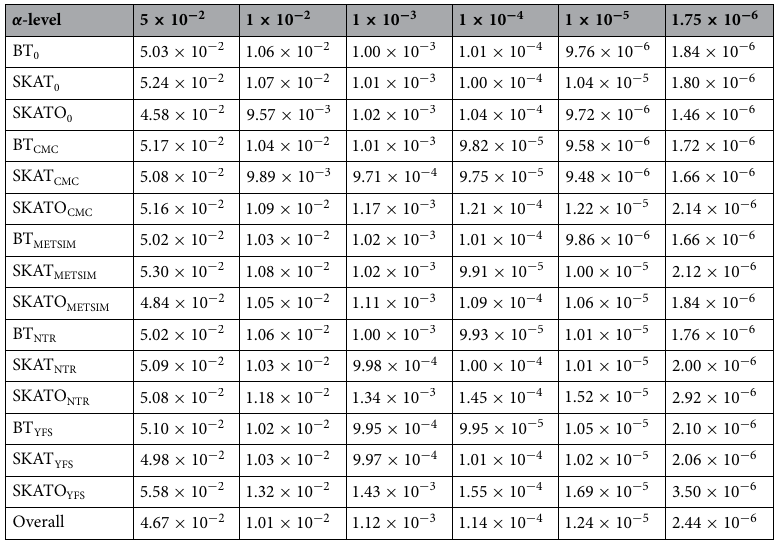
Table 2. Estimated type I error rates at different significance levels with 10 7 replications. The subscript denotes BT, SKAT, and SKATO using eQTL—derived weights; CMC, METSIM, NTR, and YFS indicate the resources to obtain the eQTL—derived weights. 0 indicates the methods without using eQTL—derived